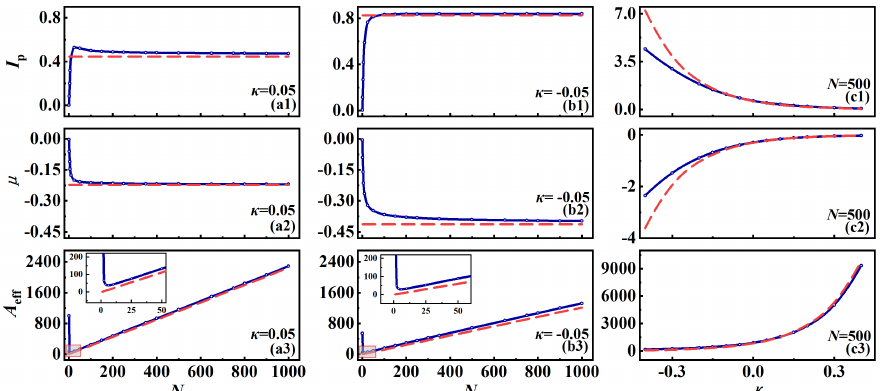
Figure 3. The first column ( a1 – a3 ): the peak density ( I P ), chemical potential ( µ ), effective area ( A eff ) of the fundamental QDs as functions of N for repulsive DDIs with κ = 0.05. The second column ( b1 – b3 ): the I P , µ , and A eff of the fundamental QDs as functions of N for attractive DDIs with κ = − 0.05. The last column ( c1 – c3 ): the I P , µ , and A eff of the fundamental QDs as functions of the strength of κ with N = 500. Here, the blue curves are the results of the numerical calculation, and the red dashed curves in the panels are calculated from Equations (13), (14), and (15),